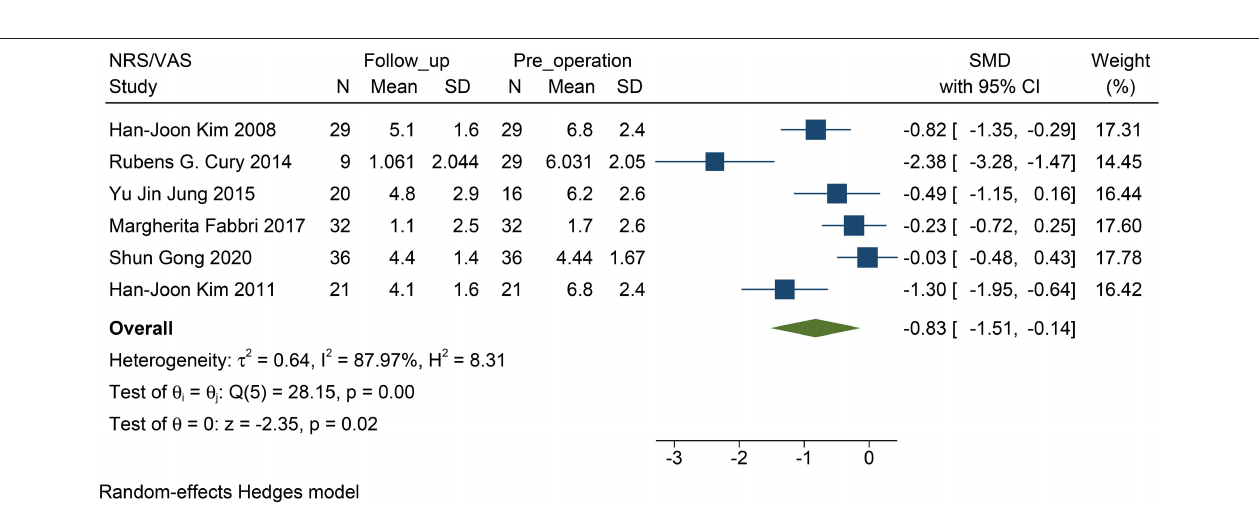
FIGURE 2 | Forest plots of pain severity: pain severity assessed by the score of miscellaneous domains including pain in the NMSS, showed a significant reduction after STN-DBS. NMSS, non-motor symptom scale; STN-DBS, subthalamic nucleus deep brain stimulation.